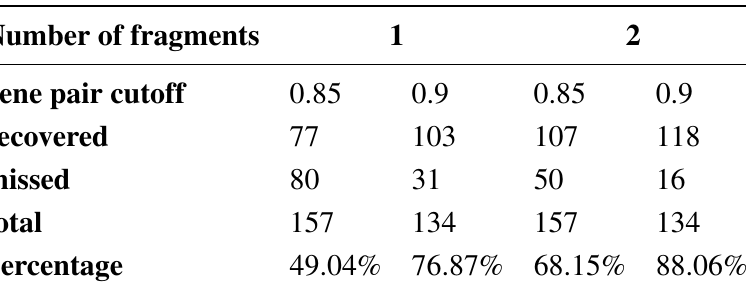
Table 1. Leave-one-out stability test result. The table shows the difference in the number of gene runs as well as percentage under different